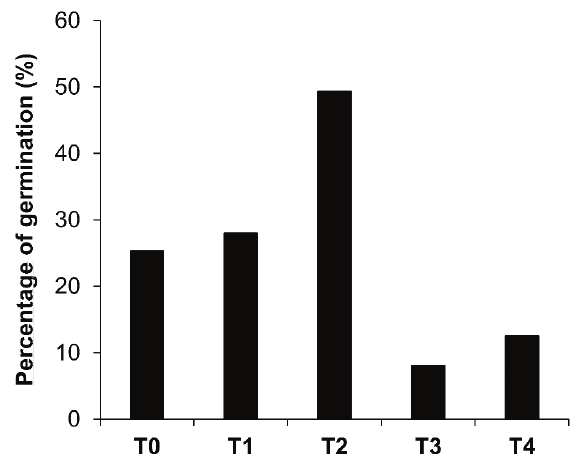
Fig. 3 ­ Effect of different warm stratification treatments on the percentage of germination of Cycas revoluta embryos.